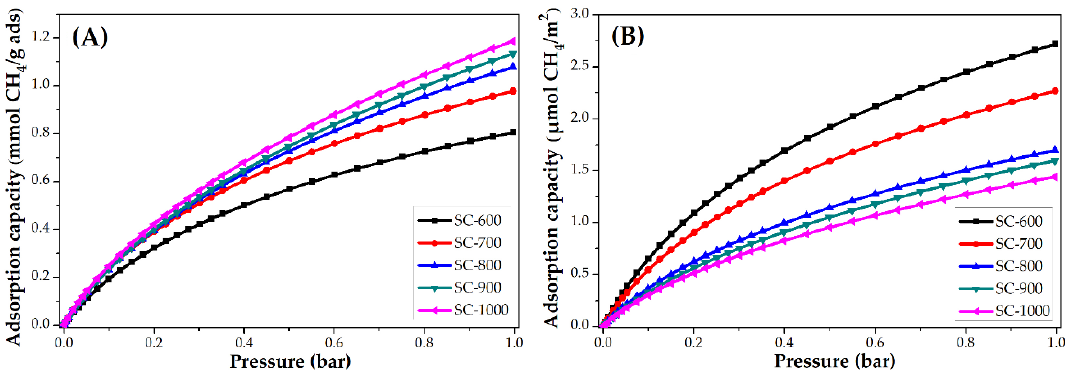
Figure 8. CH 4 adsorption isotherms at 25 °C of PANMF stabilized a 280 °C and carbonized: ( A ) mmol CH 4 /g adsorbent and ( B ) µmol CH 4 /m 2 .